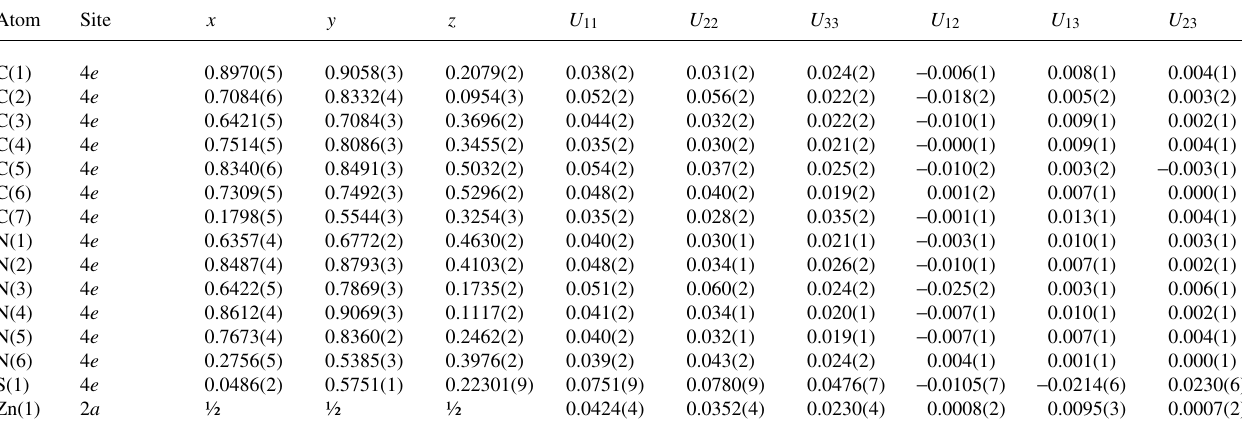
Table 3. Atomic coordinates and displacement parameters (in Å 2 )